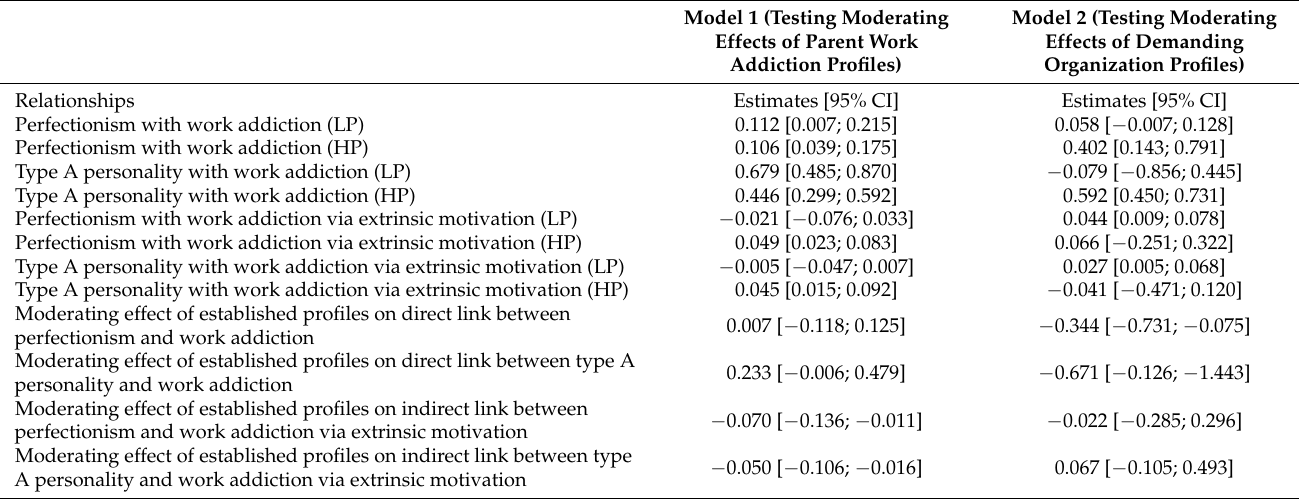
Table 5. Results of multi-group SEM